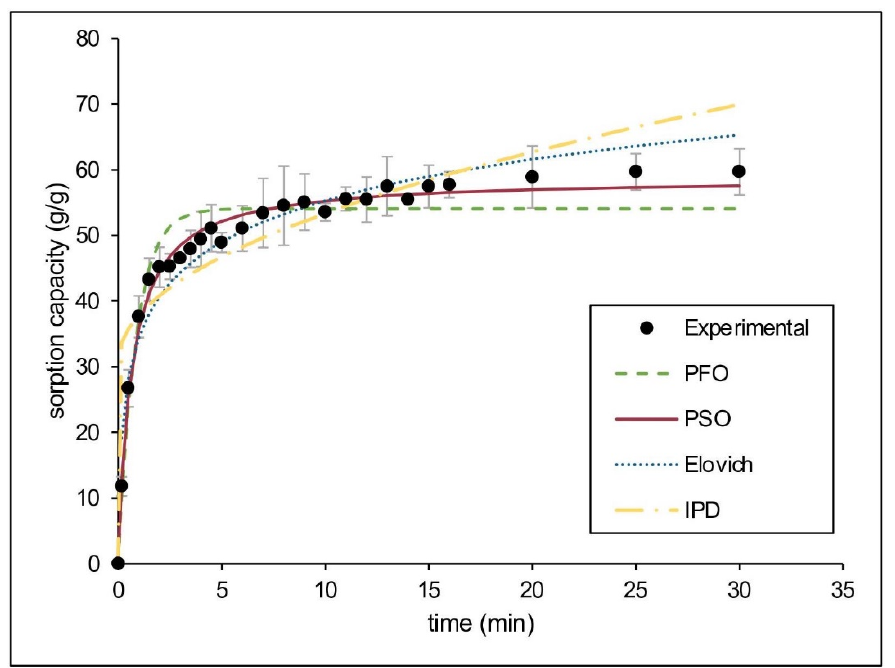
Figure 8. (Color online) Kinetic modeling of experimental data for motor oil sorption by CaSt 2 -KF. Table 3. Summary of kinetic model parameters from linear and nonlinear curve fitting of experimental data for motor oil sorption by CaSt 2 -KF.